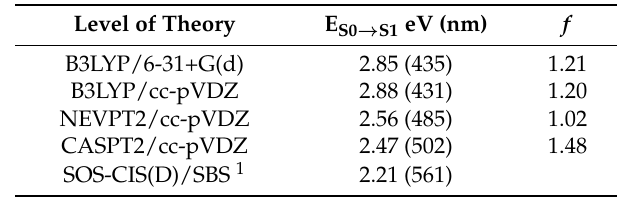
Table 1. Vertical excitation energies ( E S0 → S1 ) and oscillator strengths ( f ) at different levels of theory and basis sets, including data from the literature.